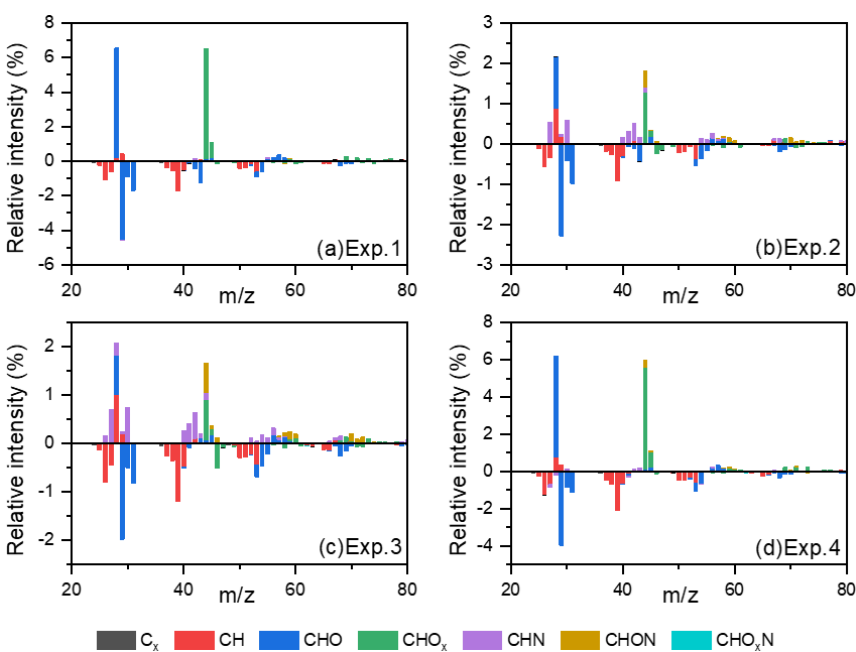
Figure 4. The differential spectra of toluene SOA in the formation and stable stages. Data were taken and analyzed at a high resolution but were summarized to a unit mass resolution for display. Only minimal N-containing fragments could be observed in Exp. 1 without added NH 3 and NO x . These N-containing fragments could be attributed to the background NH 3 and NO x in the chamber or systematic errors from